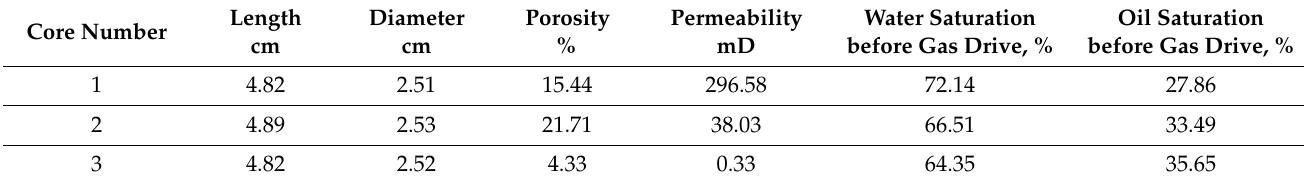
Table 2. Core physical properties and oil–water saturation parameters before injection–production experiment.